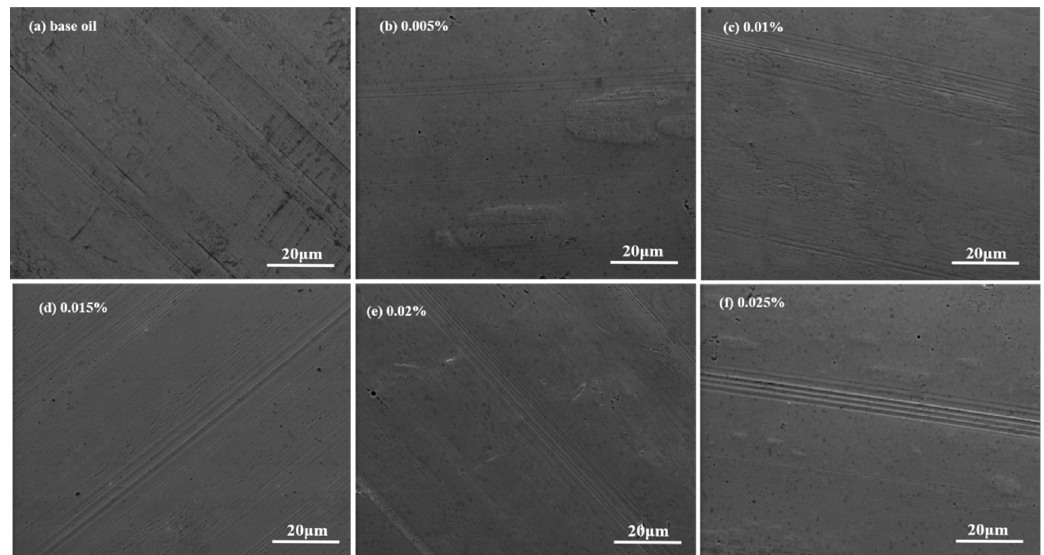
Figure 7. SEM images of the wear scar on the surface of the steel ball after friction in the oil samples with di ff erent additions of ML-MSH / CGB: ( a ) base oil ( b ) 0.005 wt% ( c ) 0.01 wt% ( d ) 0.015 wt% ( e ) 0.02 wt% ( f ) 0.025